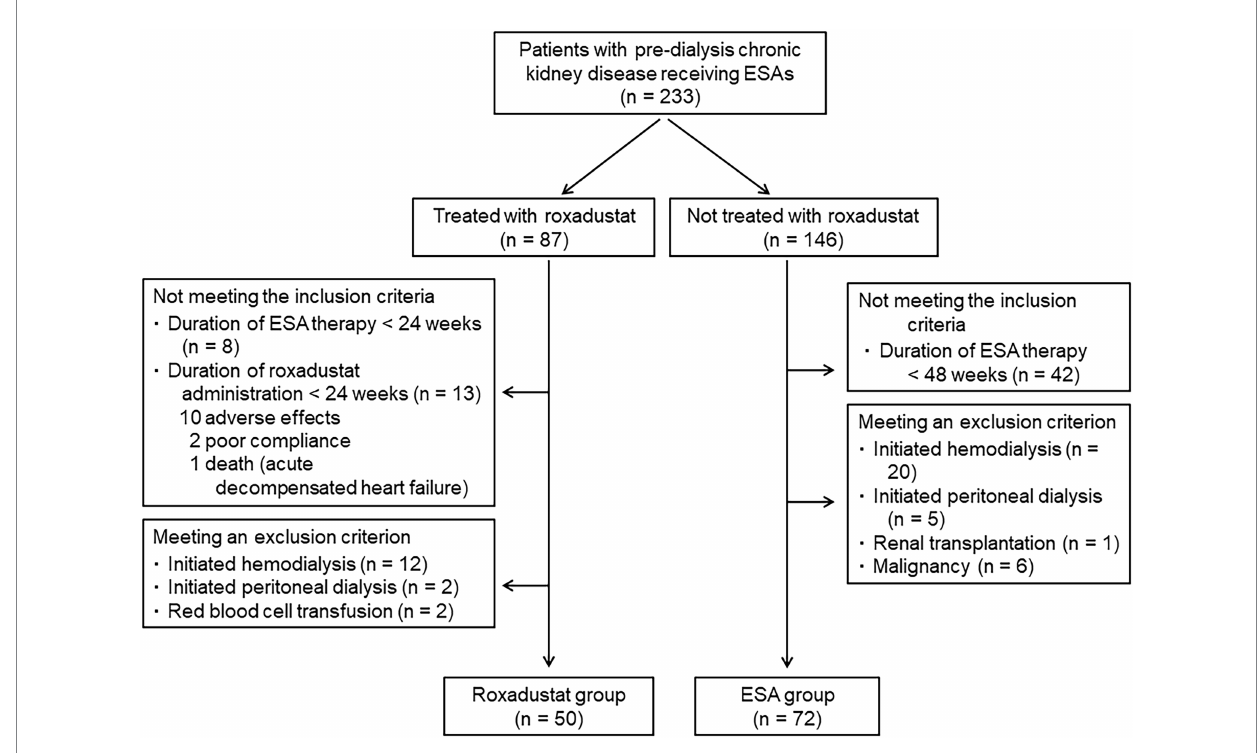
FIGURE 2 Patient flow diagram. ESA, erythropoiesis-stimulating